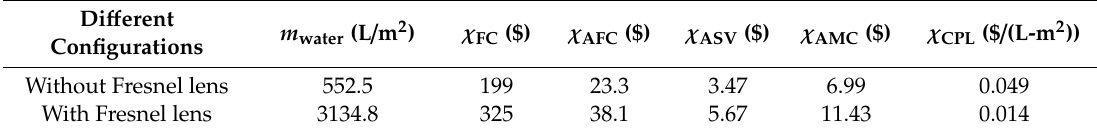
Table 9. Cost of solar still configurations with and without FRL used in experiments